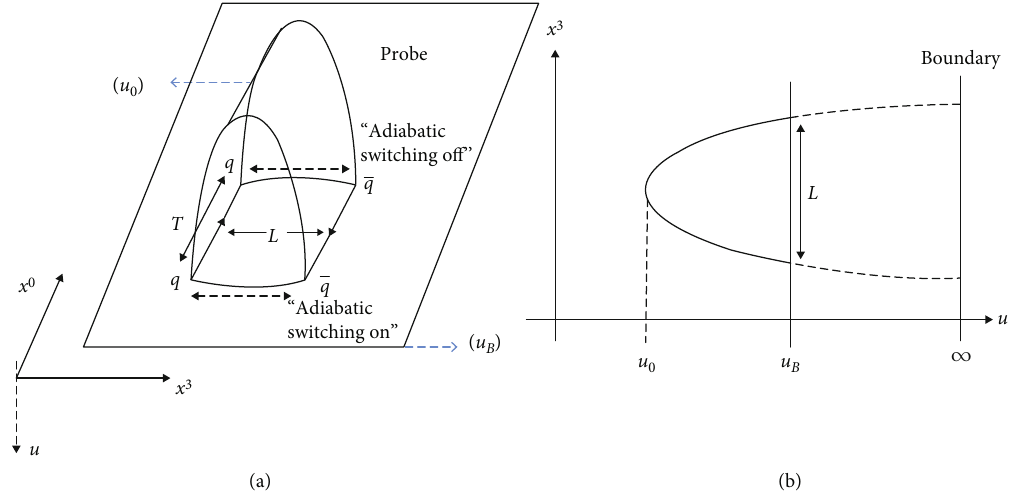
) on the holographic direction as in (b). On the B